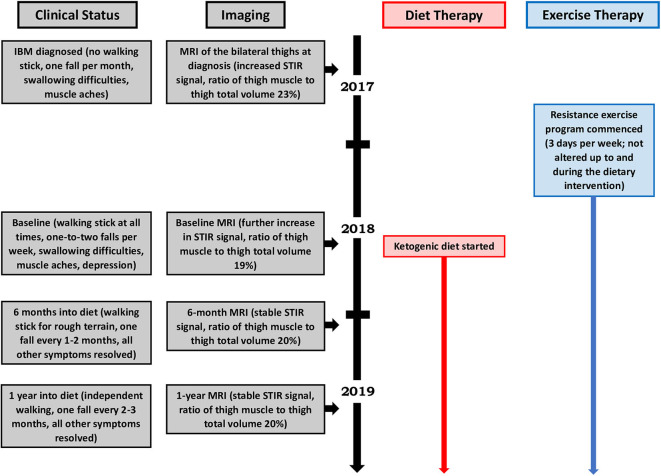
Patient timeline.